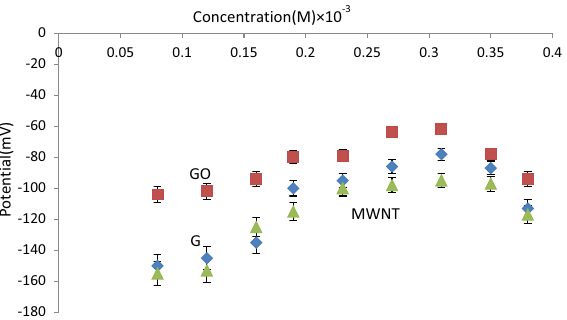
Figure 13. Potential responses for different PVC membrane electrodes with graphite, graphene oxide and multi-walled nanotubes.